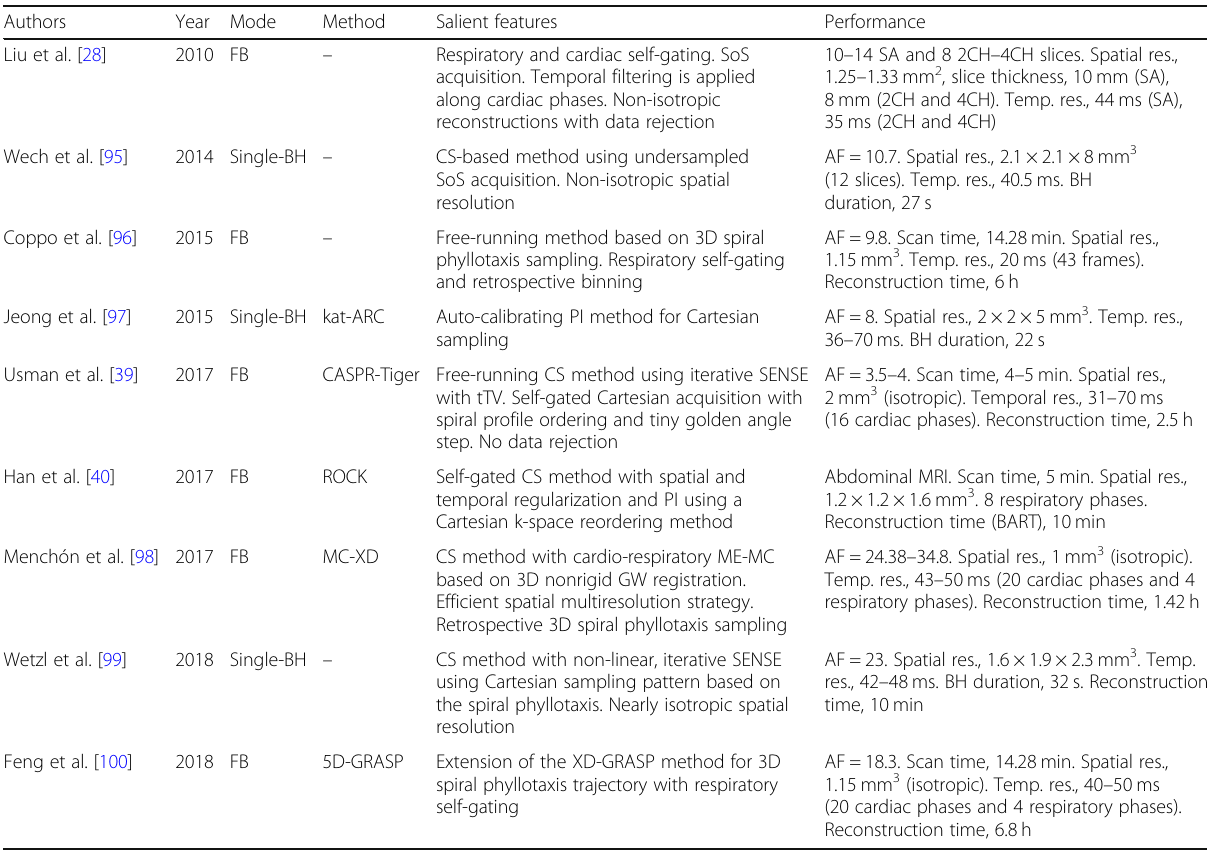
Table 2 Summary of reconstruction techniques for 3D cine CMRI